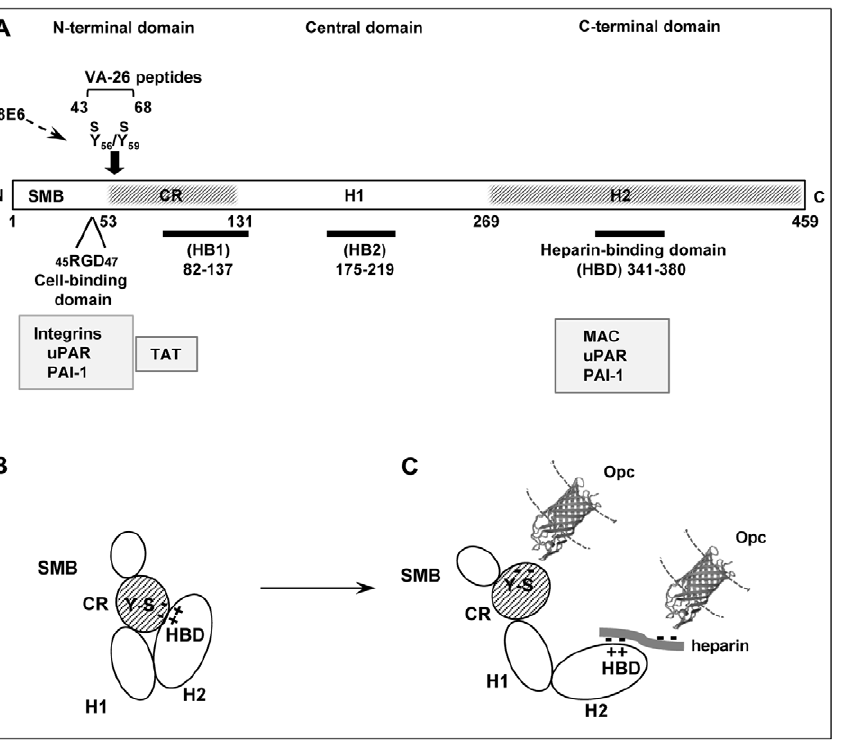
Figure 9. Vitronectin domain structure, conformational states and some physiological and bacterial ligand binding sites. (A) A schematic presentation of linear vitronectin structure showing the positions of the cell-binding motif RGD, sulphated tyrosines (Y 56 S/Y 59 S) and the high affinity heparin-binding domain (HBD), the three regions of particular importance in meningococcal interactions with host receptors. The N- terminal domain contains a region homologous to somatomedin B, (SMB, residues 1–44). The central and the C-terminal domains contain regions homologous to haemopexin (H1 and H2). An extended connecting region (CR) joins the N-terminal and the central domains and contains a stretch of acidic residues (53–61) within which two sulphated tyrosines (Y-S) are located. This site is cryptic in the native vitronectin and comprises the mAb 8E6 binding epitope requiring the presence of sulphated residues [30]. The C-terminal domain residues 341–380 contain the main heparin-binding domain (HBD) and are composed of several highly charged residues [26]. Arginine at positions 351/353 may bind directly to heparin [45]. Two other sites implicated in heparin binding (but with low affinity) are shown as HB1 and HB2. Several pathogens bind to the central domain and via heparin to HBD [46,64,65]. Only Nm has been shown in our current study to bind to the Y-S region in the vitronectin connecting region. Binding positions for physiological ligands are shown (grey boxes). Information is partly based on [23,26,27] and references there in. (B) An illustration of the folded conformation of the vitronectin molecule which may bring the acidic sulphated tyrosines and the basic HBD in close proximity [23]. (C) Under physiological or in vitro denaturing conditions, Vn structure is relaxed exposing fully the HBD binding site and making available the mAb 8E6 epitope in the CR, both with the capacity to bind to N. meningitidis Opc protein. The binding at the HBD may additionally be assisted by the multimerisation of Vn, which increases the affinity of multimeric Vn for heparin [27]. The molecular model of Opc was kindly provided by Prof. Jeremy Derrick. The Opc crystal structure has been described by Prince et al . [17]; this study also presents a model of the possible mechanism of interaction of the Opc surface exposed loops with heparin-like proteoglycans.